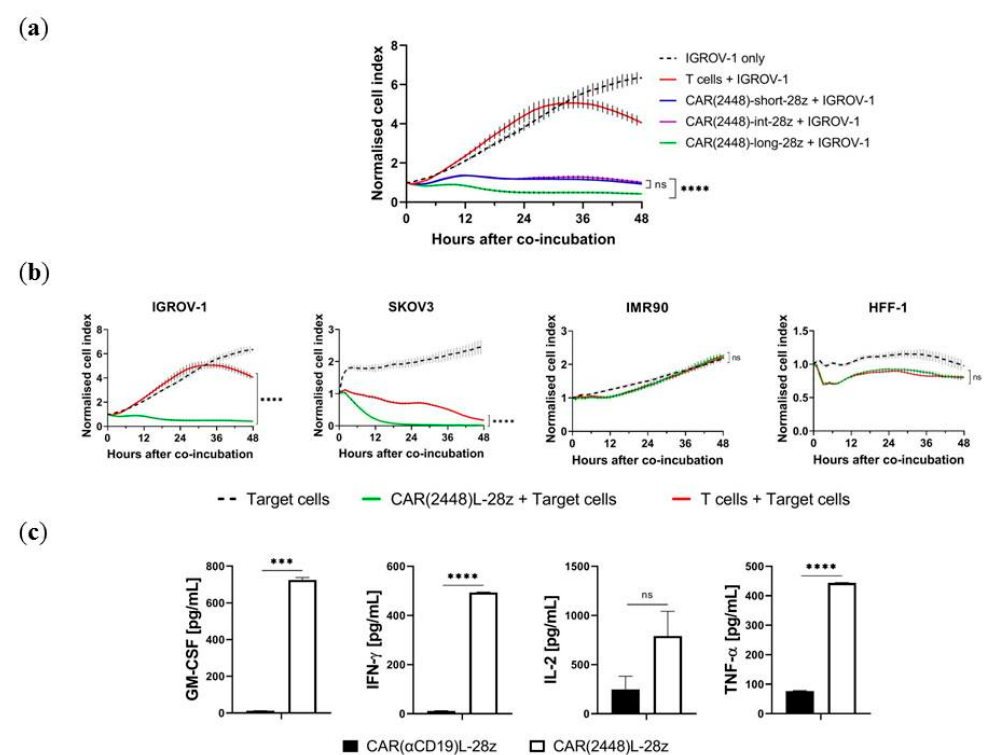
Figure 2. mRNA transfected chimeric antigen receptors (CAR)(2448) T cells mediate cytotoxicity. ( a ) CAR(2448)-long-28z T cells mediate superior cytotoxicity against IGROV-1 cells compared to CAR(2448)-short-28z or CAR(2448)-int-28z T cells. ( b ) CAR(2448)L-28z T cells mediate cytotoxicity against target cells expressing annexin A2 (IGROV-1 and SKOV-3), but not control cell lines (HFF-1 and IMR90). Co-culture conducted at 20:1 effector-to-target (E:T) ratio. ( c ) Co-incubation of CAR T cells with target IGROV-1 cells at a 10:1 E:T ratio induces inflammatory cytokine release for CAR(2448)L but not CAR( α CD19)L. For all subfigures, abbreviations: ns not significant. *** p < 0.001. **** p < 0.0001.